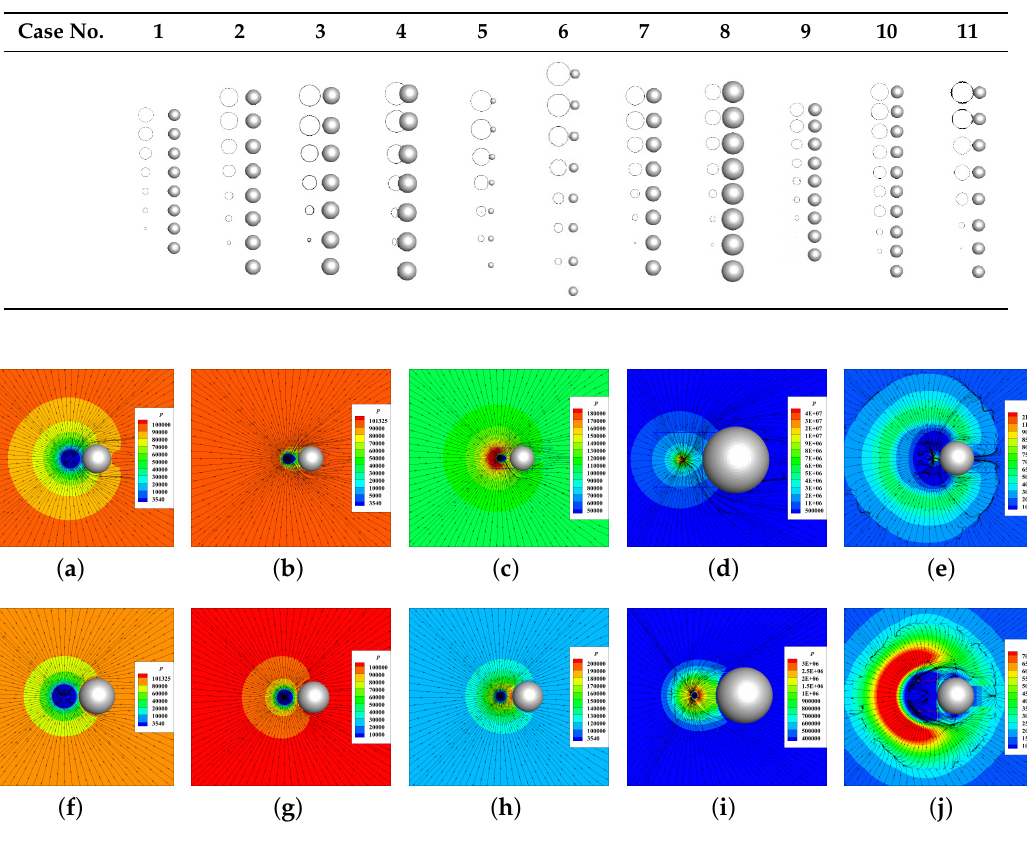
Figure 8. The patterns of streamline for case 8 in Table 2 with static particles ( a – e ) and movable particles ( f – j )